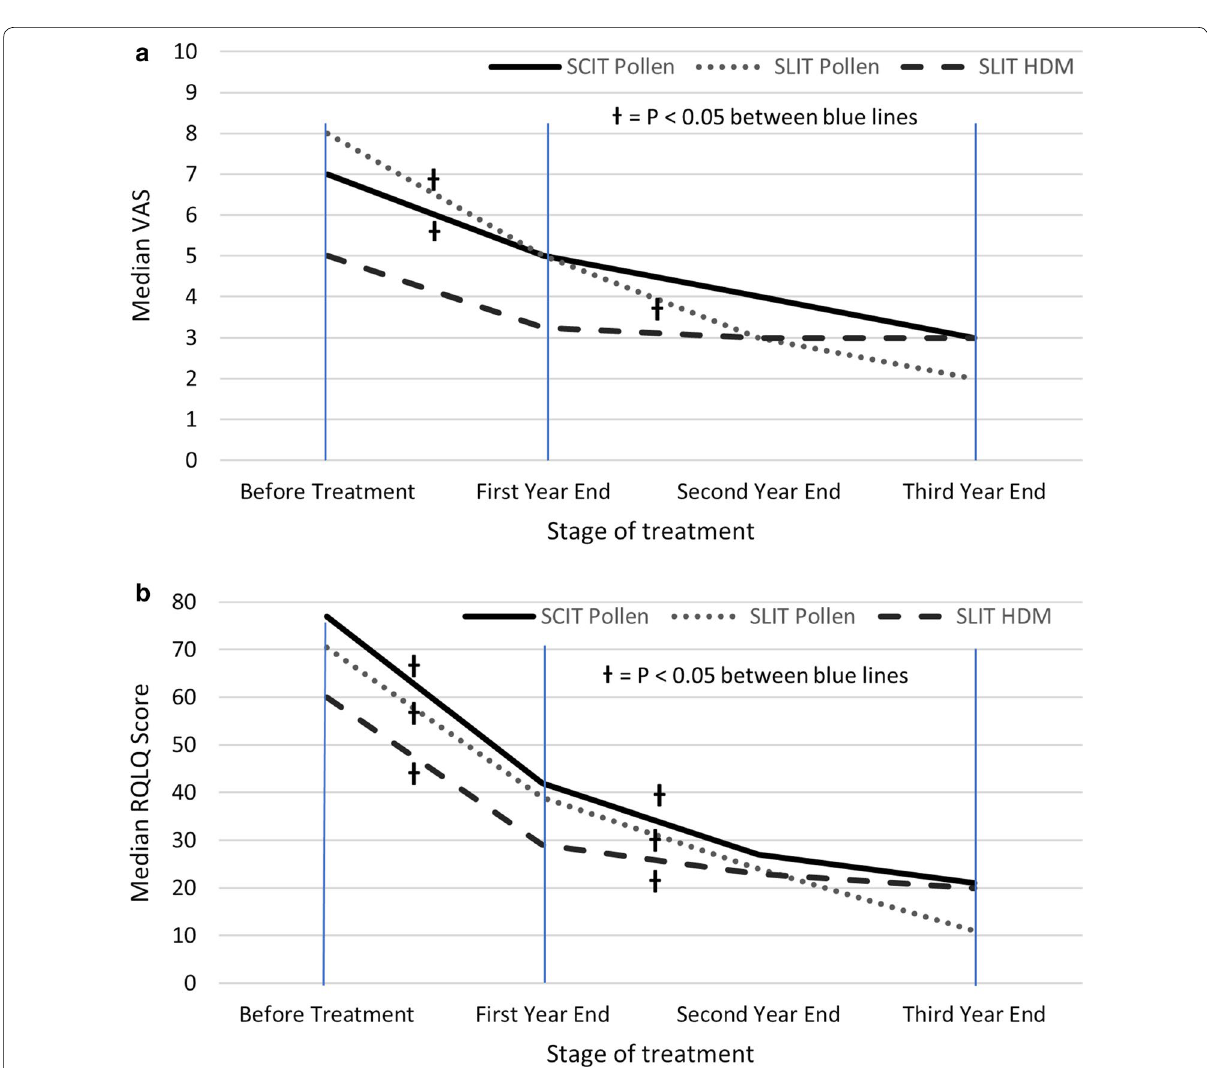
Fig. 2 Changes in median Visual analogue and RQLQ scores with AIT. a Visual Analogue Score, b RQLQ score at baseline and annual intervals. Excludes patients who have discontinued. †P < 0.05 for Wilcoxon signed rank test between baseline and 1 year, or between 1- and 3-years